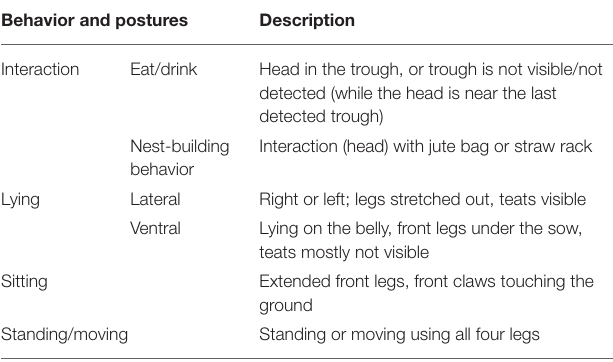
TABLE 3 | Ethogram of sow behavior/postures based on the study by Baxter et al. (2011). Behavior and